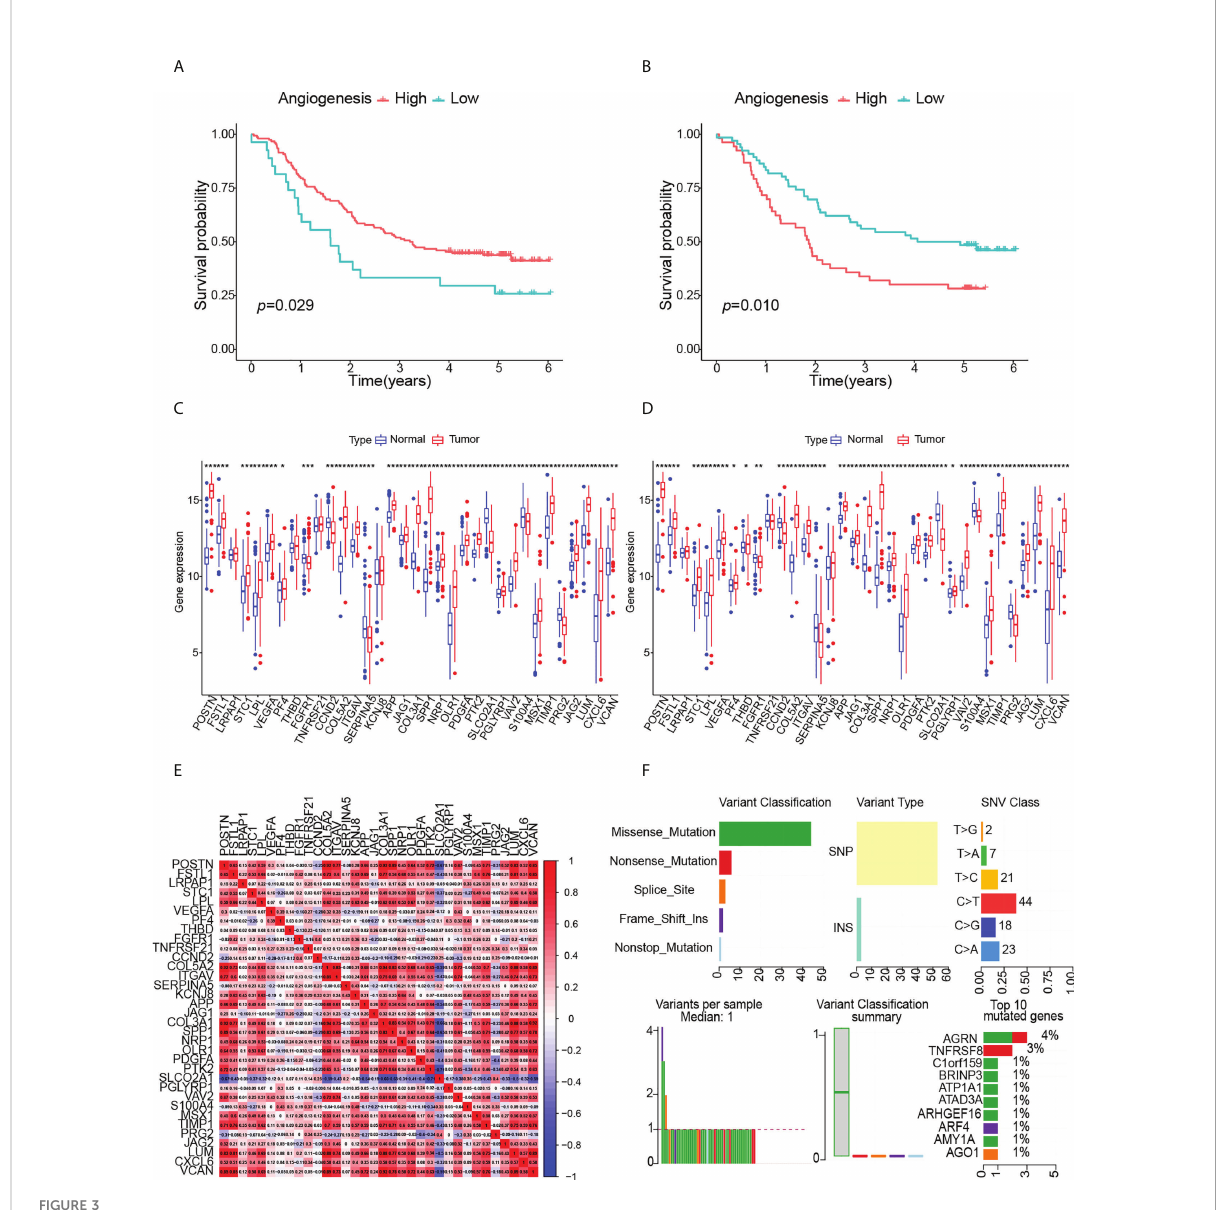
FIGURE 3 Effects of angiogenesis on prognosis and analysis of angiogenesis genes, (p values were showed as: *p < 0.05; **p < 0.01; ***p < 0.001). (A) Kaplan-Meier curve of OS for high- angiogenesis and low- angiogenesis groups in GSE53625. (B) Kaplan-Meier curve of OS for high- angiogenesis and low- angiogenesis groups in GSE53624. (C) Expression levels of angiogenesis genes in GSE53625. (D) Expression levels of angiogenesis genes in GSE53624. (E) Correlation between angiogenesis genes. (F) Landscape of somatic mutation in ESCC